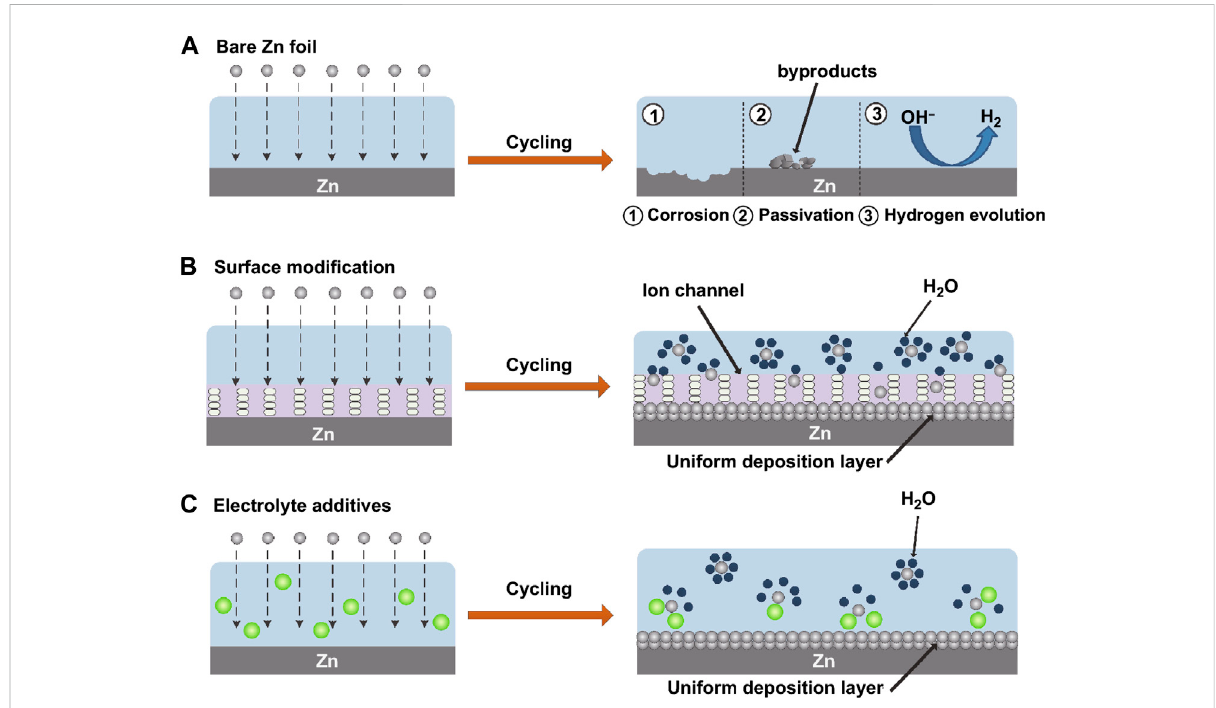
FIGURE 4 The passivation, HER and corrosion, on bare Zn. (A) A schematic illustration of coated Zn ’ s morphological development. (B) Schematic representation of the Zn ion deposition morphology after electrolyte additions. (C) CC-BY Creative Commons Attribution 4.0 International license was used to permit this reproduction (Li et al., 2022). Copyright (2022), Springer